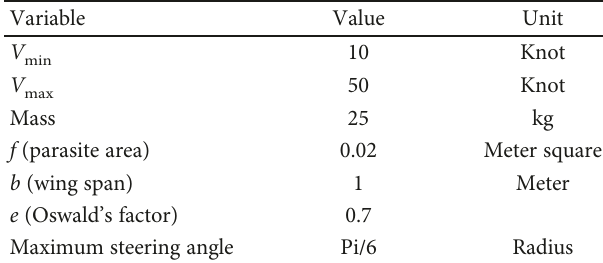
Table 3: SUAV parameters.